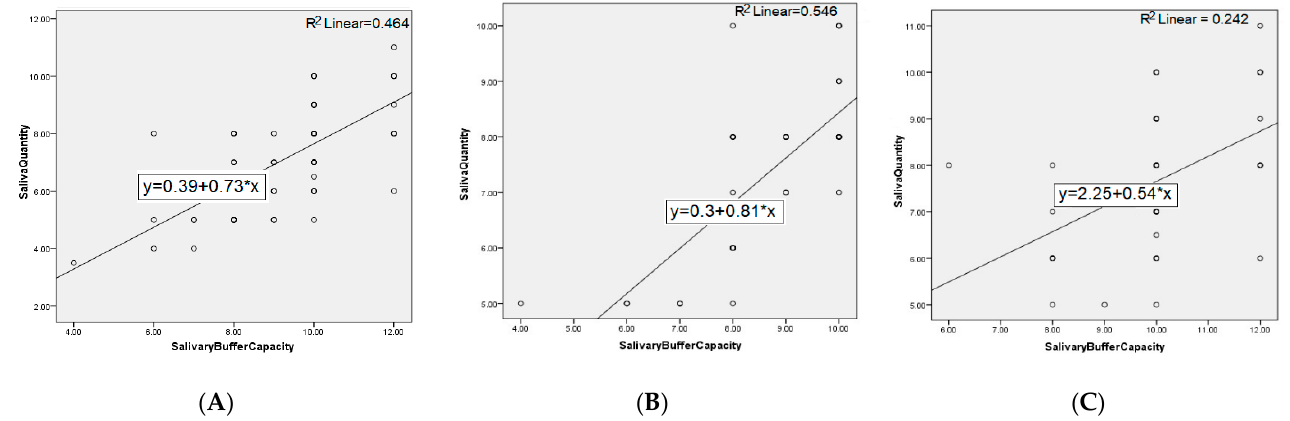
Figure 3 . Correlation between salivary flow and buffer capacity for: ( A ) entire population, ( B ) GERD patients, and ( C ) controls.